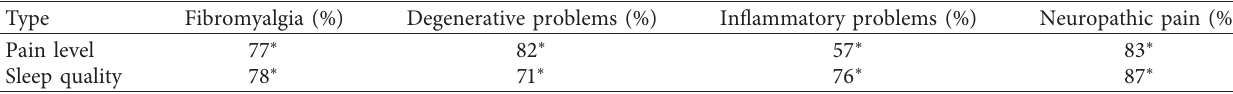
Table 3: Pain and quality of sleep mean response to MC treatment.